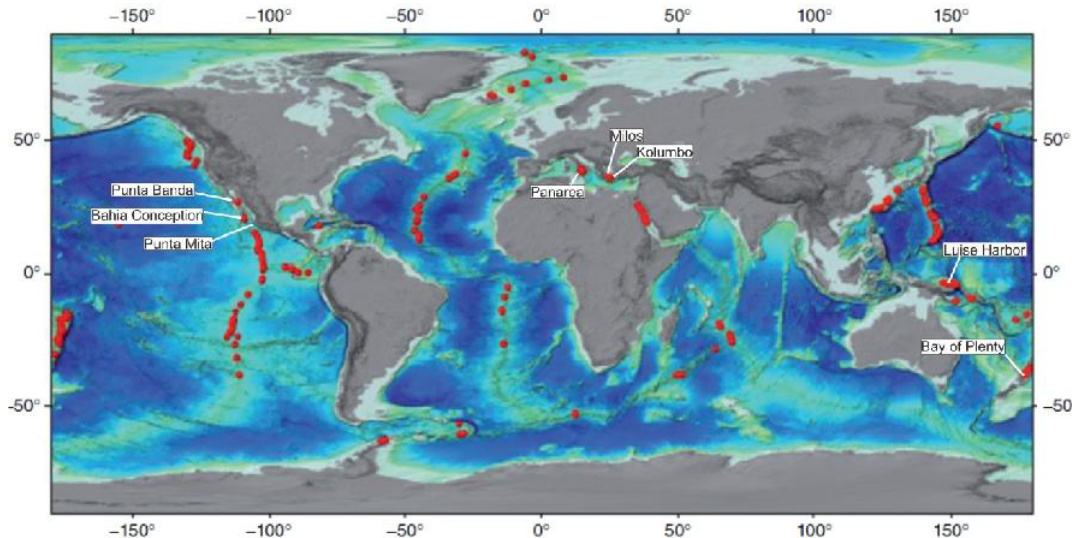
Figure 1. Map showing the location of hydrothermal deposits discovered on the seafloor including locations of some very shallow and shallow‐water hydrothermal vents discussed in this study (adapted from Jamieson et al. [42]).